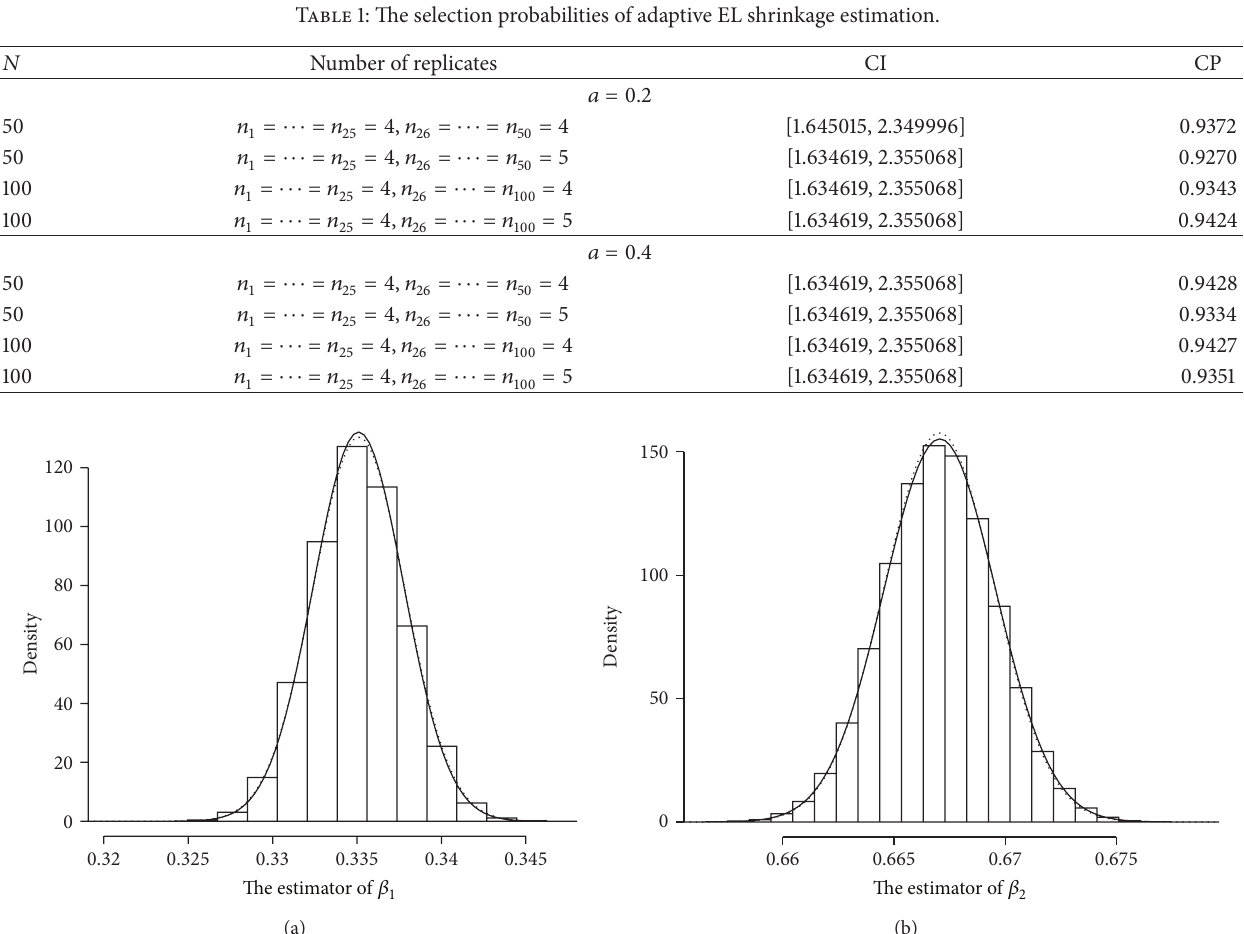
Figure 2: The histograms of the 1000 estimators of every parameter, the estimated curve of density (solid curve) and the curve of normal density (dased curve): (a) for 𝛽 1 and (b) for 𝛽 2 .